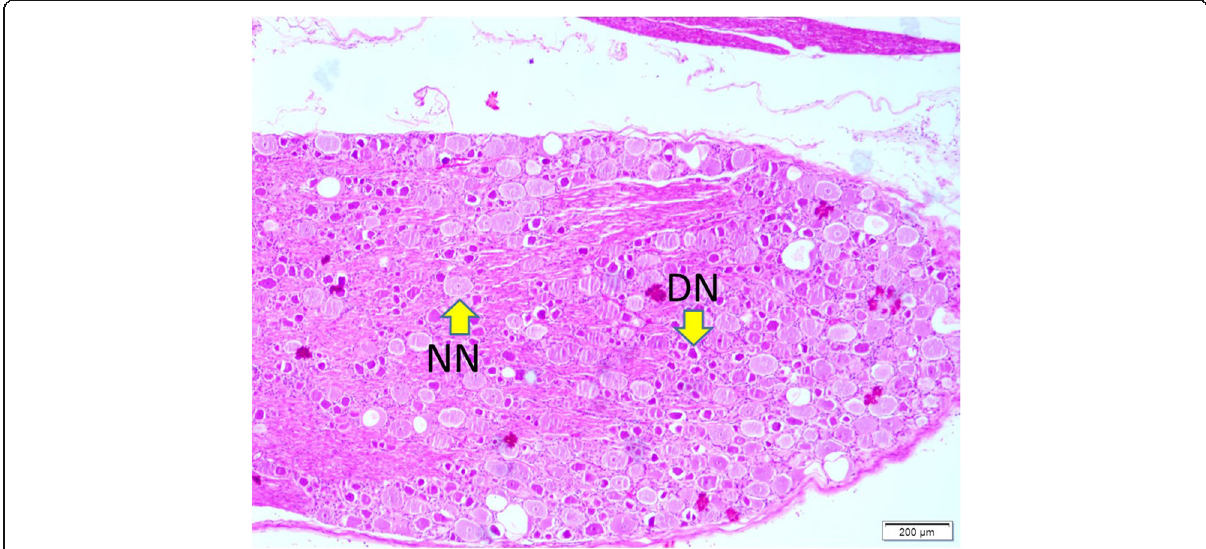
Fig. 8 Histopathological appearance of normal (NN) and degenerated (DN) neurons, including DRG, in an animal that underwent monopolar cautery (LM, H&E, × 10/A)